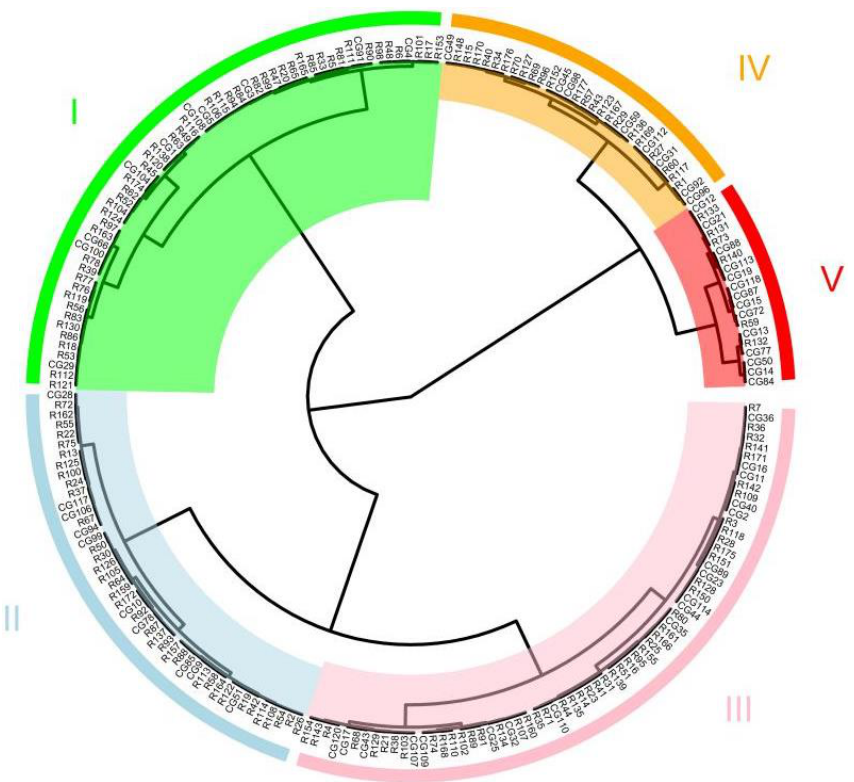
Figure 2. Cluster analysis of salt tolerance of core accession seedlings based on salt injury index. The I, II, III, IV, and V indicates Group I, Group II, Group III, Group IV, and Group V, respectively.